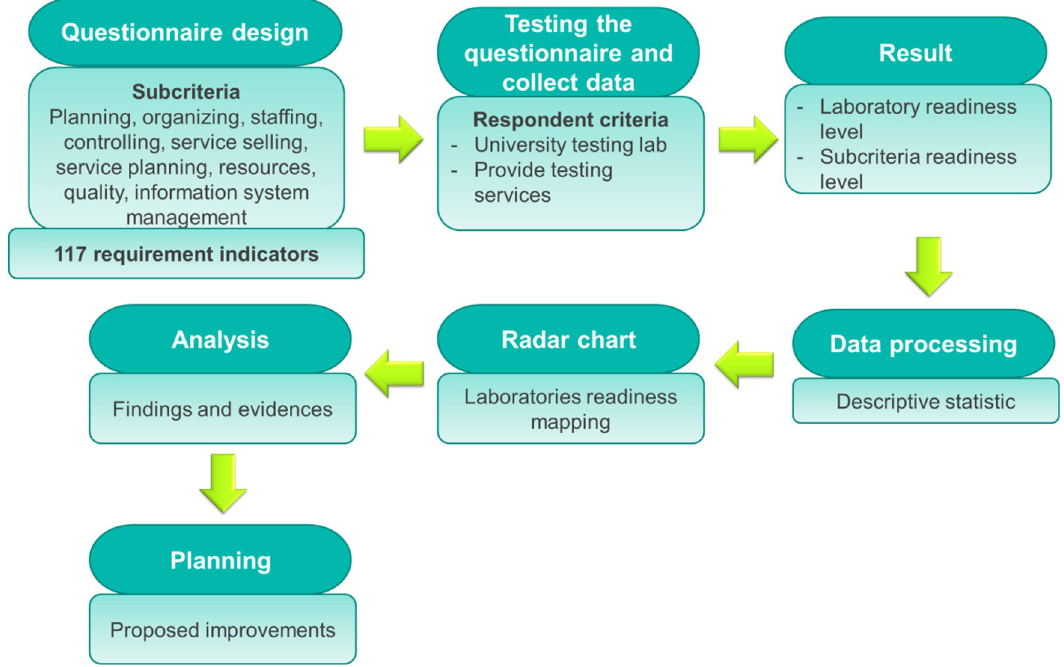
Figure 4. University testing laboratories readiness assessment framework.